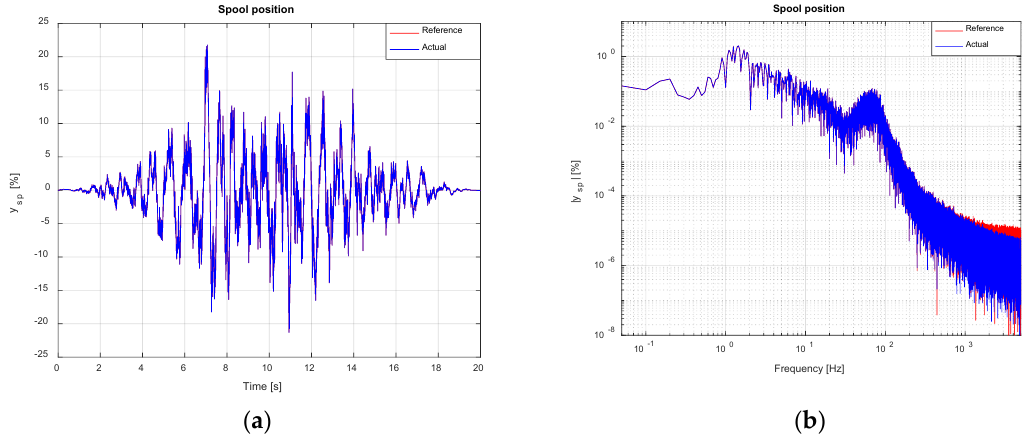
Figure 15. Spool position tracking (noise-free scenario). TVC disabled: ( a ) Time domain; ( b ) Frequency